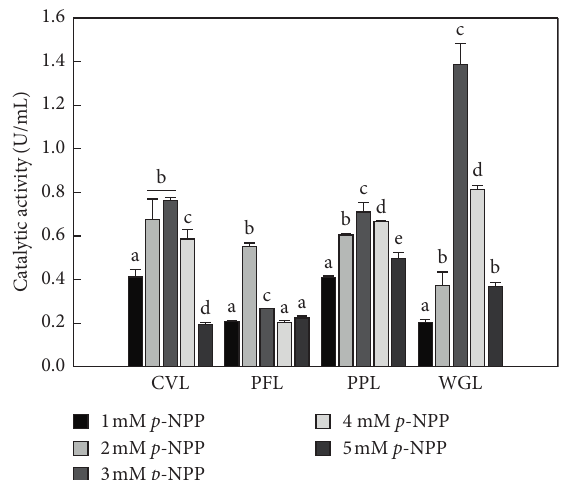
Figure 1: Effects of substrate ( p -nitrophenyl palmitate, p -NPP) concentration on the catalytic activity of lipases. The substrate concentration was in the range of 1–5 mM. Error bars indicate the standard error of the mean. Superscripts (a–e) above the bars denote significant differences in catalytic activity ( p < 0 . 05 , Dun- can’s multiple range test on ANOVA). CVL, Chromobacterium viscosum lipase (0.01mg/mL); PFL, Pseudomonas fluorescens lipase (0.001mg/mL); PPL, porcine ( Sus scrofa ) pancreatic lipase (10mg/ mL); WGL, wheat germ ( Triticum aestivum ) lipase (1mg/mL).